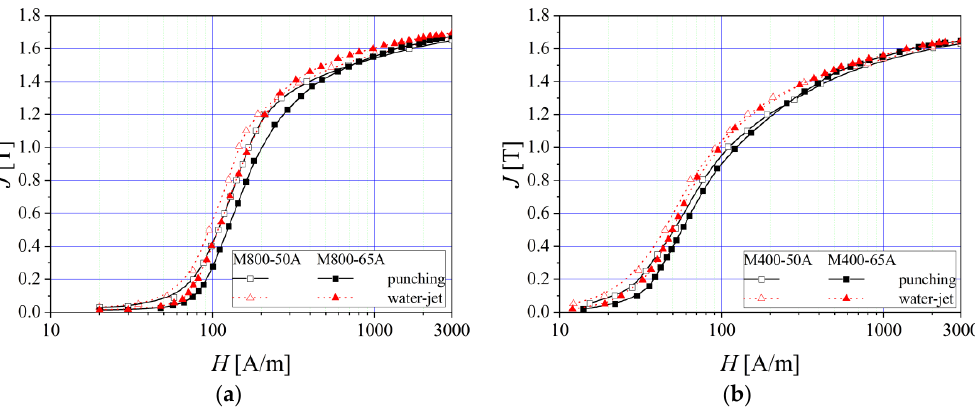
Figure 4. Normal magnetization curves of two electrical steel types ( a ) M800 and ( b ) M400, in the case of different sample thickness (0.50 mm and 0.65 mm).